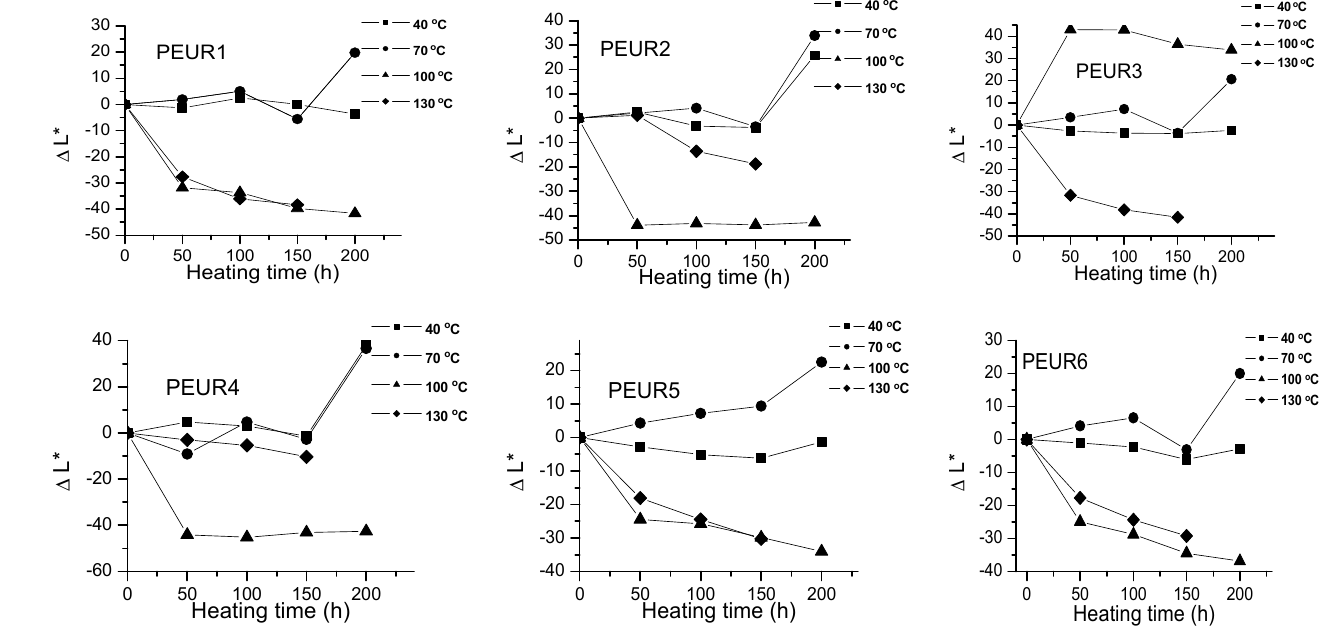
Figure 2. Variation of Δ L * with temperature and heating time of PEURs. The negative Δ L * values indicate surface darkening during the thermal treatment of the PEURs. For PEURs 1, 2, 3, 5 and 6 treated at 40 and 70 °C, a slight discoloring may be observed through minor increases in Δ L * values. For PEUR4, up to 150 h and at 40, 70 and 100 °C, Δ L * values are positive. At over 150 h of thermal aging at 100 and 130 °C the Δ L * values become negative, hence the samples darken. For the thermal treatments of PEURs 1, 2, 3, 5 and 6 at 100 and 130 °C the Δ L * values also become negative. For sample PEUR3 at 100 °C a strong discoloration may be observed in the first 50 h. PEUR1 darkens at temperature values below 100 °C and at lower temperatures and it lightens after 100 h. For the thermal treatment at 40 °C, Δ L * values of PEUR1 vary very little with time. At 40 and 70 °C PEUR2 shows minor modifications of Δ L * up to 150 h, after which it lightens, Δ L * strongly increasing. For thermal treatments at 130 °C PEUR2 slowly darkens up to 150 h, after which it strongly lightens. Red and yellow degradation intermediates accumulate on the surface of samples during the thermal treatment, as it can be seen from Figure 3, Figure 4 and Table 2. The displacements of Δ a * and Δ b * to either positive or negative values do not show any pat- tern. This is an indication of the formation of highly instable colored intermediates dur- ing thermal aging. 0